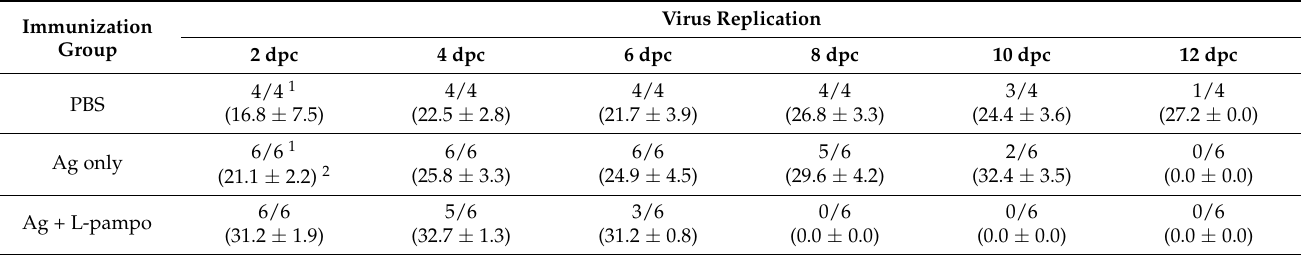
Table 1. Ferrets immunized with L-pampo protect against SARS-CoV-2 virus challenge. Immunization Group